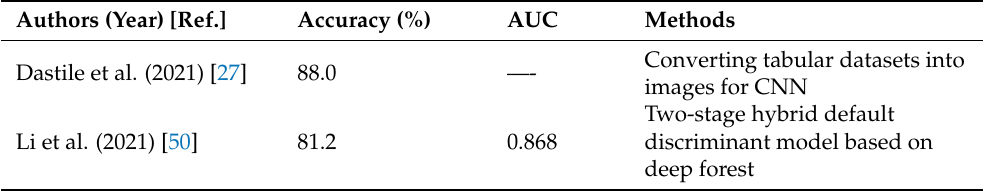
Table 8. Accuracy and area under the receiver operating characteristic curve (AUC) values of deep-learning-based classifiers for the German (categorical)